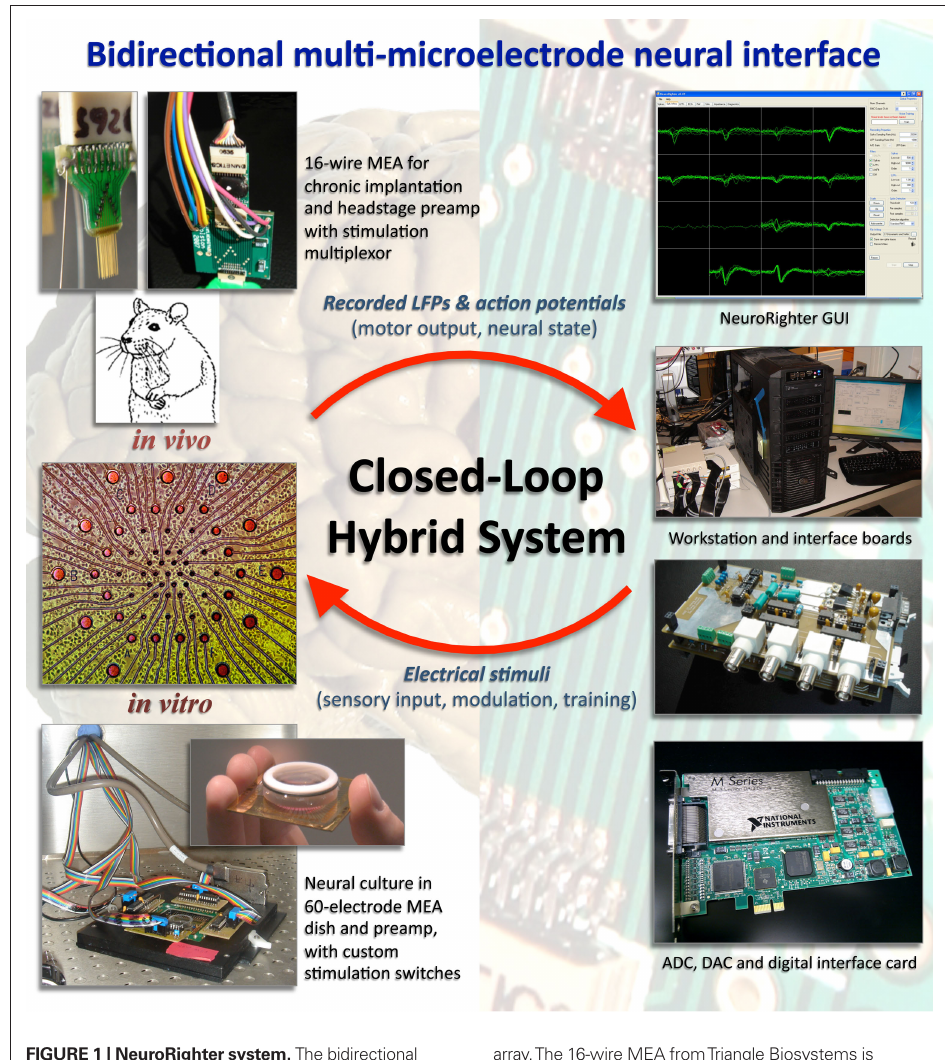
Figure 1 | Neurorighter system. The bidirectional multi-microelectrode system consists of custom interface circuit boards, a computer with National Instruments PCI-6259 multifunction cards, and the NeuroRighter control software. Interface boards are modular and stackable, so adding channels is straightforward. For freely moving animals, the in vivo components also include a recording headstage and stimulator headstage, which connect to the animal’s chronically implanted electrode